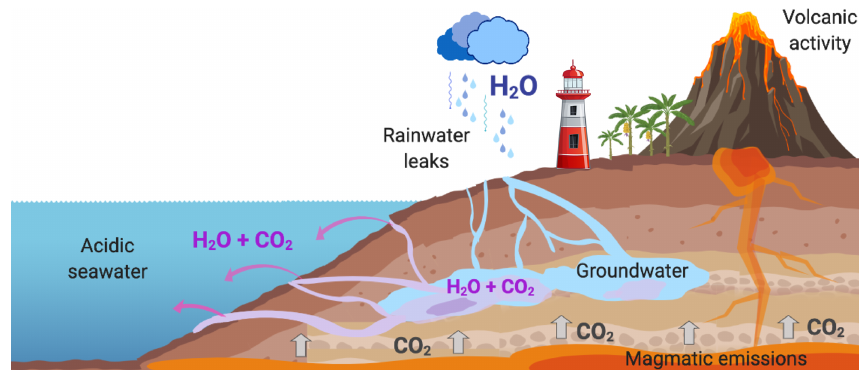
Figure 5. Acidification process representation of the Punta de Fuencaliente system (PFS) (made with